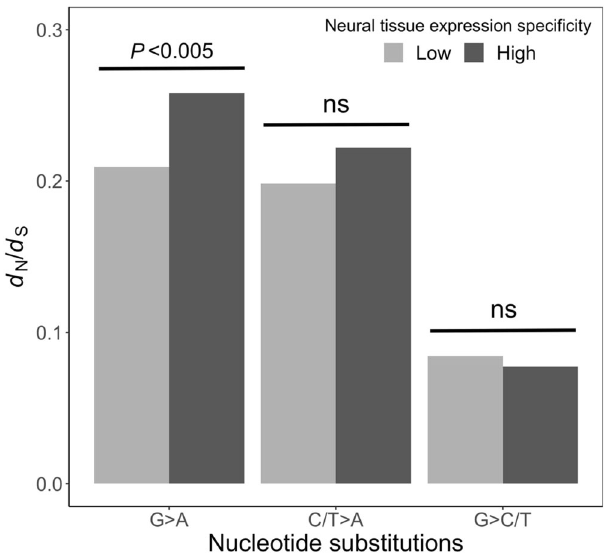
Fig. 3 Coleoid nonsynonymous to synonymous substitution rate ratios ( d N / d S ) for various nucleotide changes. The P -value is based on 200 bootstrap samples; ns, not signi fi cant. Source data are provided as a Source Data fi